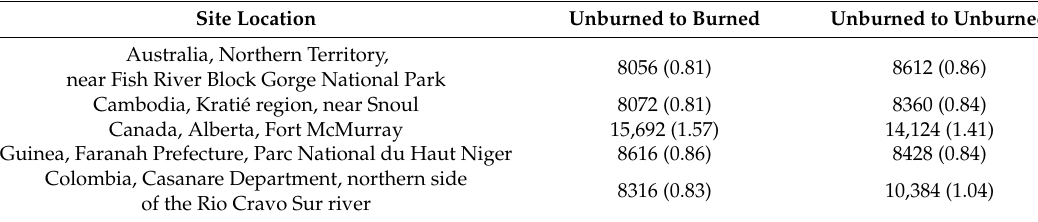
Table 4. Number of pairs of unburned (first image acquisition) to burned (second image acquisition) pixel samples and number of pairs of unburned (first image acquisition) to unburned (second image acquisition) pixel samples at 10 m resolution selected at each site. The total summed pixel areas in km 2 are shown in